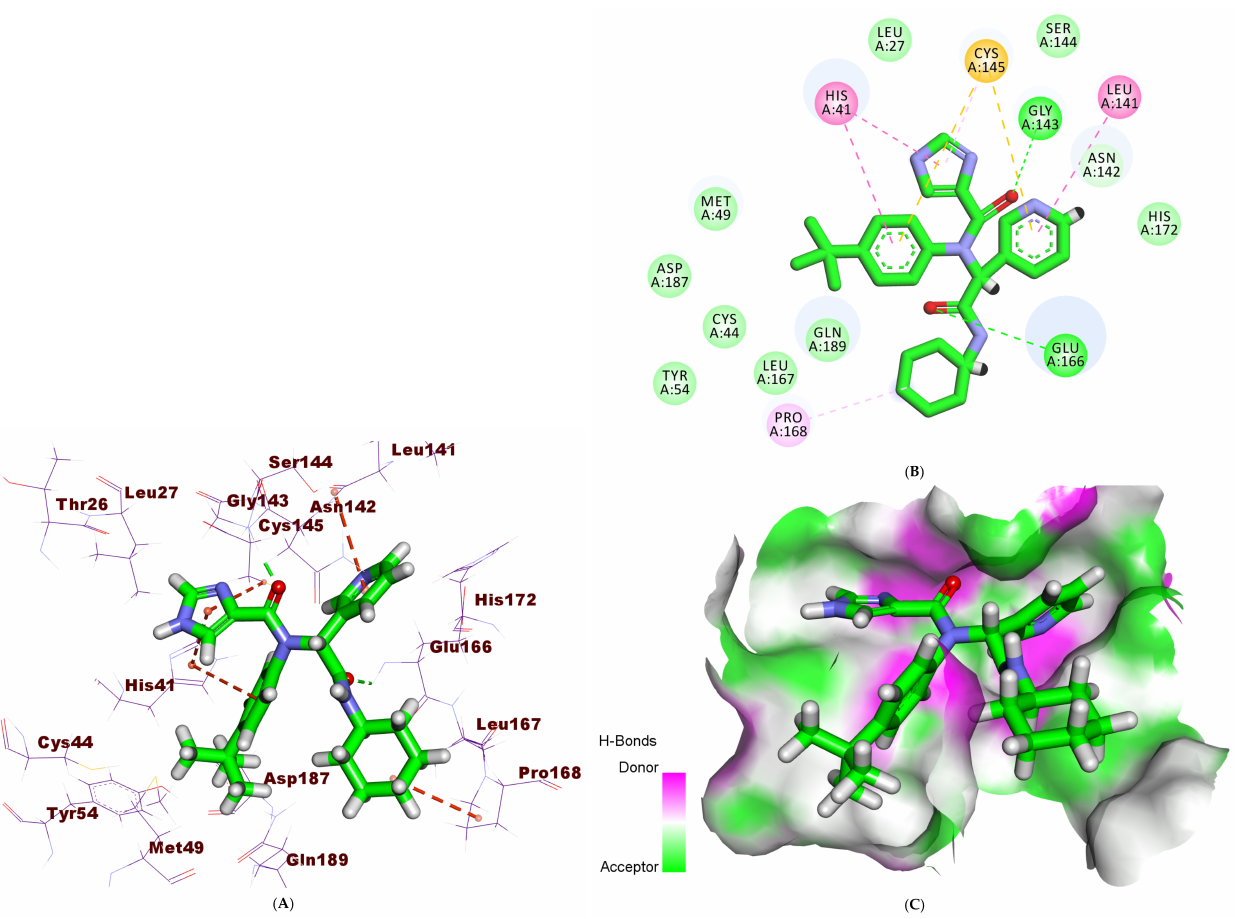
Figure 10. ( A ) 3D, ( B ) 2D, and ( C ) Surface mapping of X77 docked into the active site of M pro The